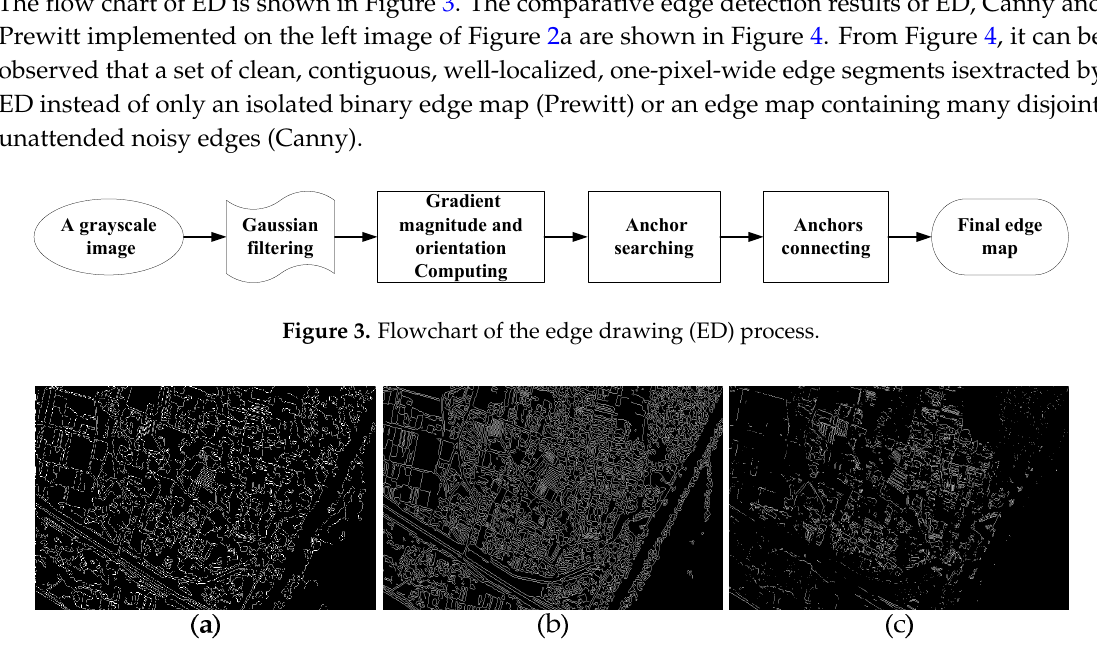
Figure 4. Edge detection results from three detectors. ( a ) ED; ( b ) Canny; ( c ) Prewitt.